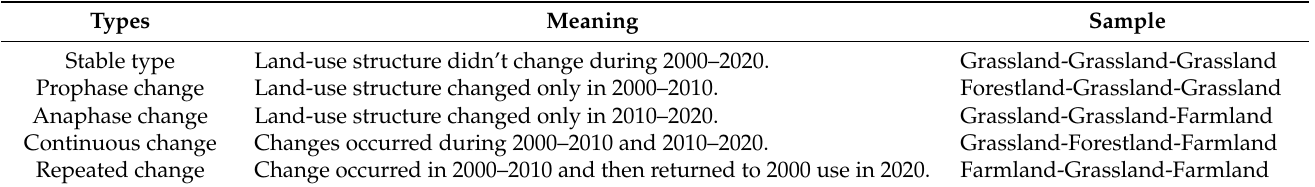
Table 3. Geo-information graphics of land-use change during 2000–2020 in the